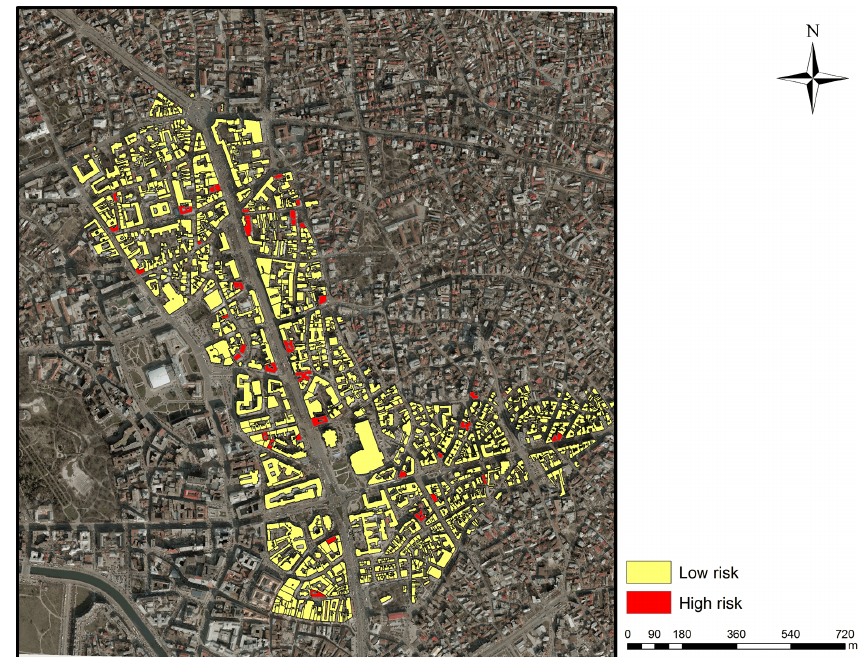
Figure 3. The N–S (Magheru) boulevard area, highlighting the risk class I buildings.